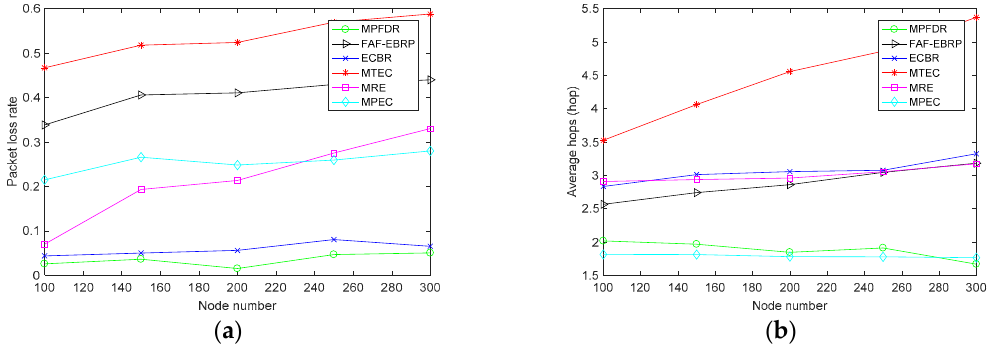
Figure 5. ( a ) PLR versus different number of nodes; ( b ) AH versus different number of nodes.